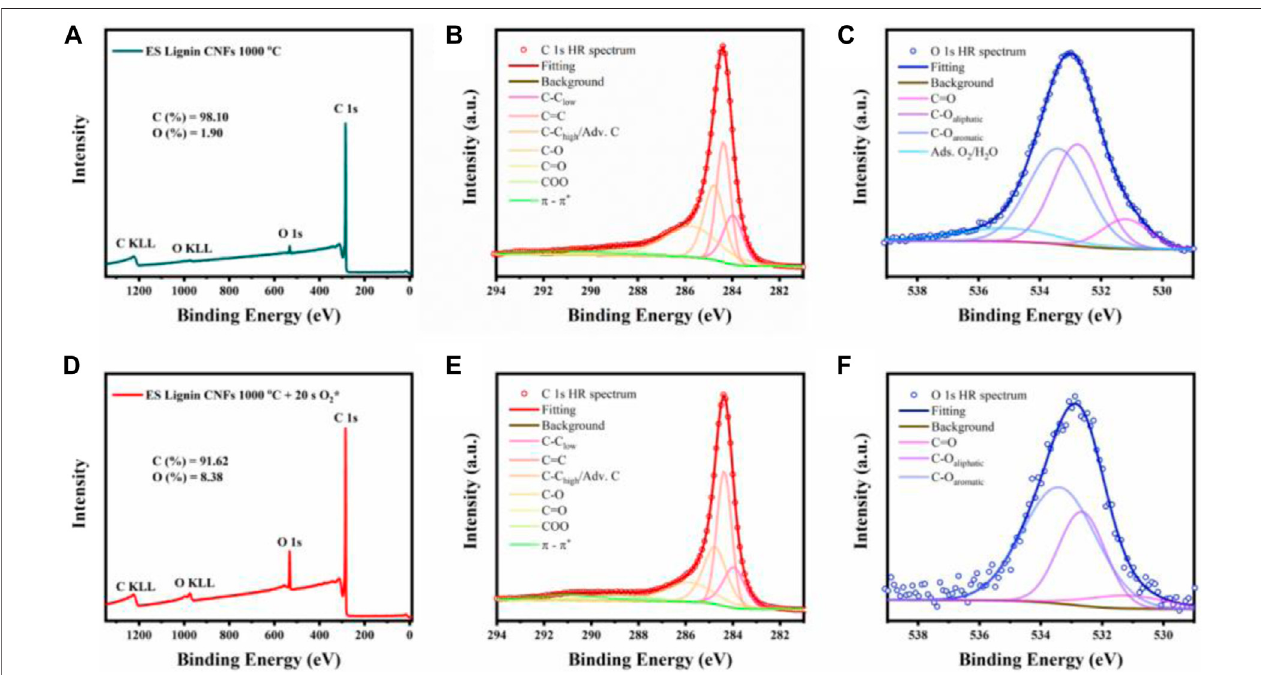
FIGURE 3 | X-ray photoelectron spectroscopy characterization, (A – C) : Survey, C 1s and O 1s analyzed spectra of ES fi bers carbonized at 1000 ° C and plasma treatment for 20 s (D – F) : Survey, C 1s and O 1s analyzed spectra of ES fi bers carbonized at 1000 ° C.